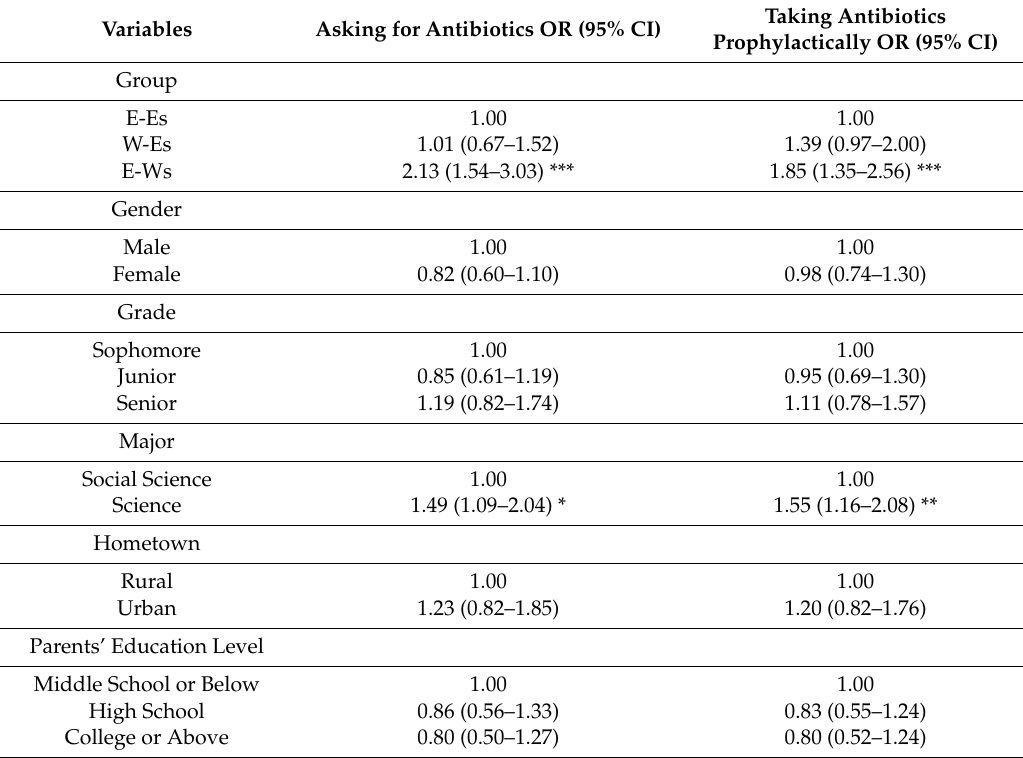
Table 4. Changes in antibiotic use behaviors among students who were from the eastern region or attended eastern universities.